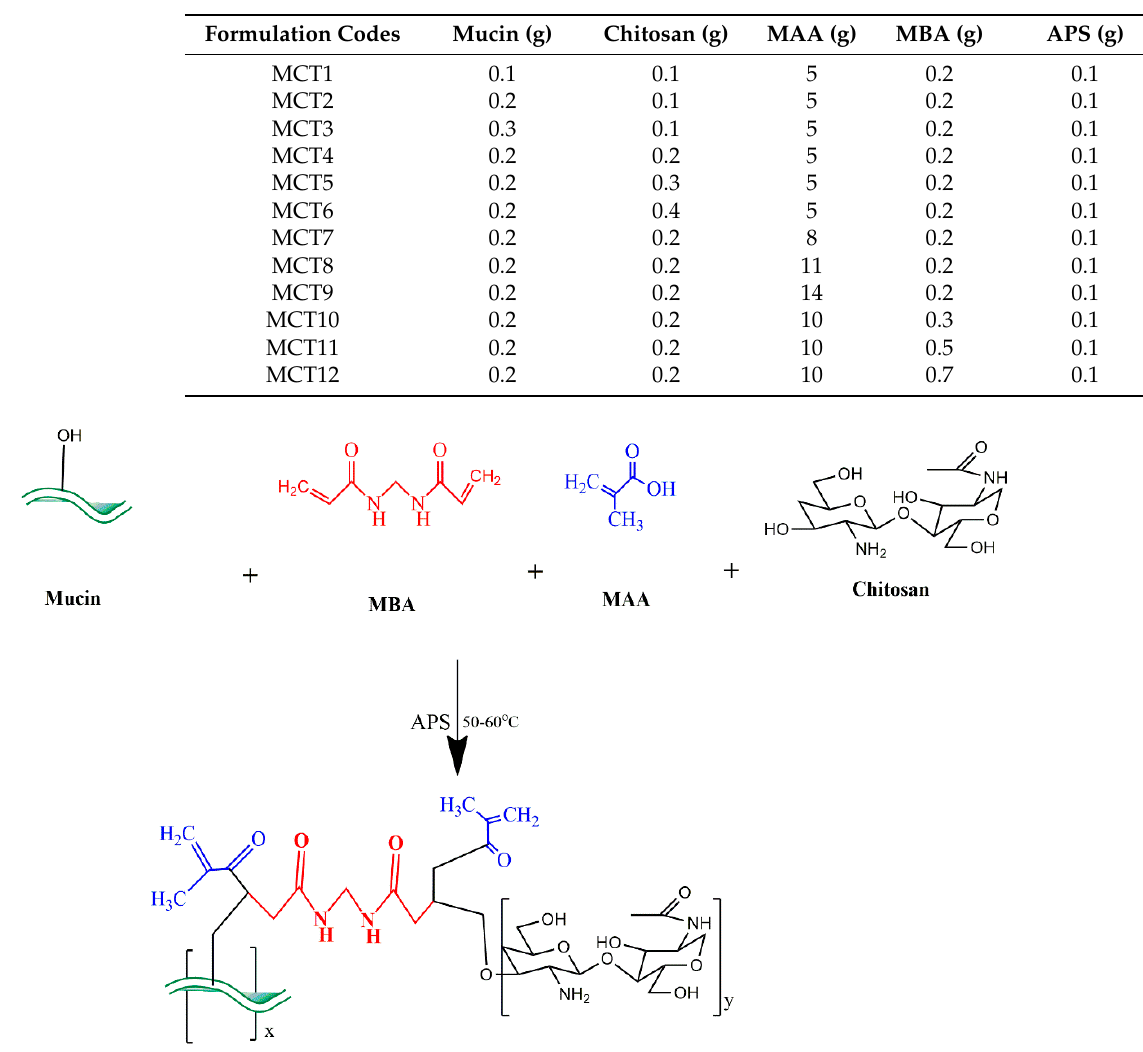
Figure 14. Proposed chemical structure of MU-CHI-Co-poly (MAA) hydrogel microparticles.